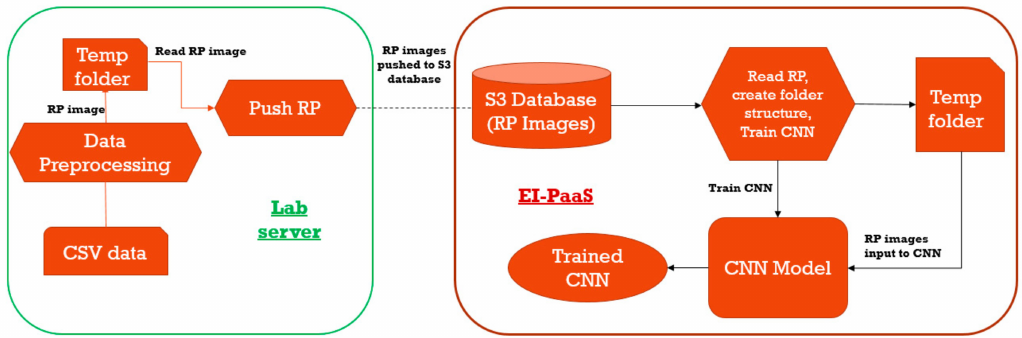
Figure 4. The architecture used while training the CNN (Convolutional Neural Network) model for motor fault diagnosis. Left: the setup used in one of the lab servers, where the historical motor data are collected and stored for di ff erent types of faults and healthy conditions. Right: this setup is on the cloud platform called EI-PaaS, where the S3 database and the CNN model are